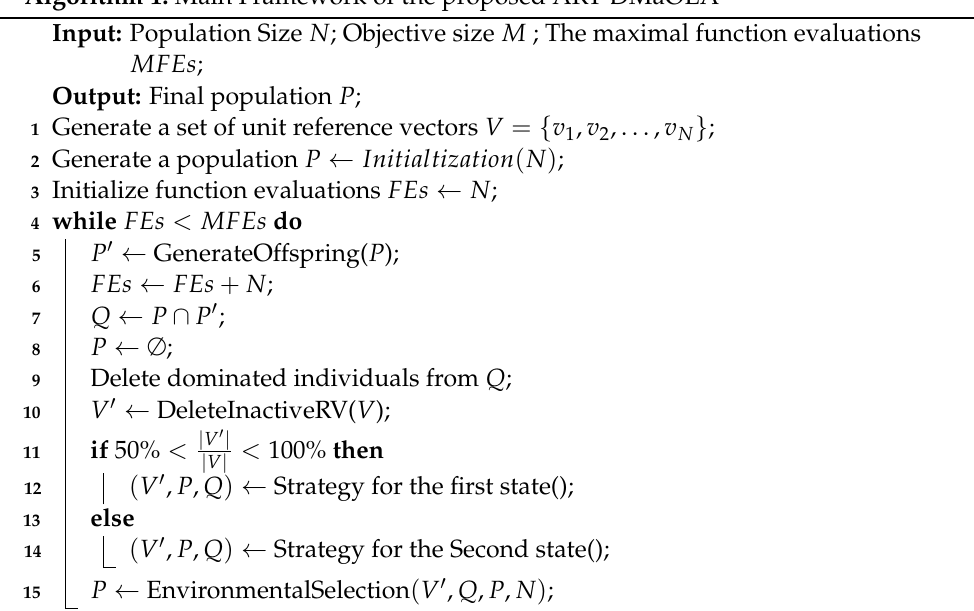
Algorithm 1: Main Framework of the proposed